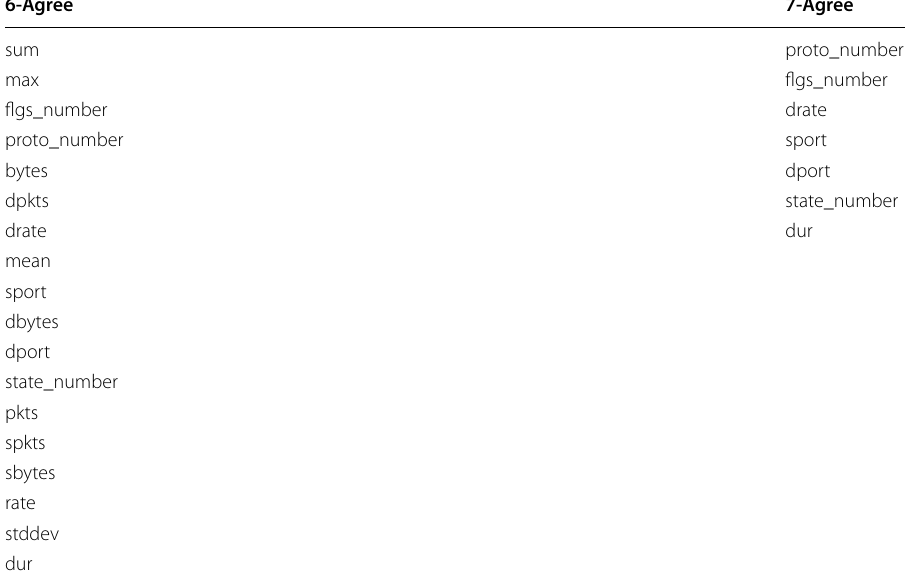
Table 54 Results of the 6-Agree and 7-Agree FSTs 6‑Agree